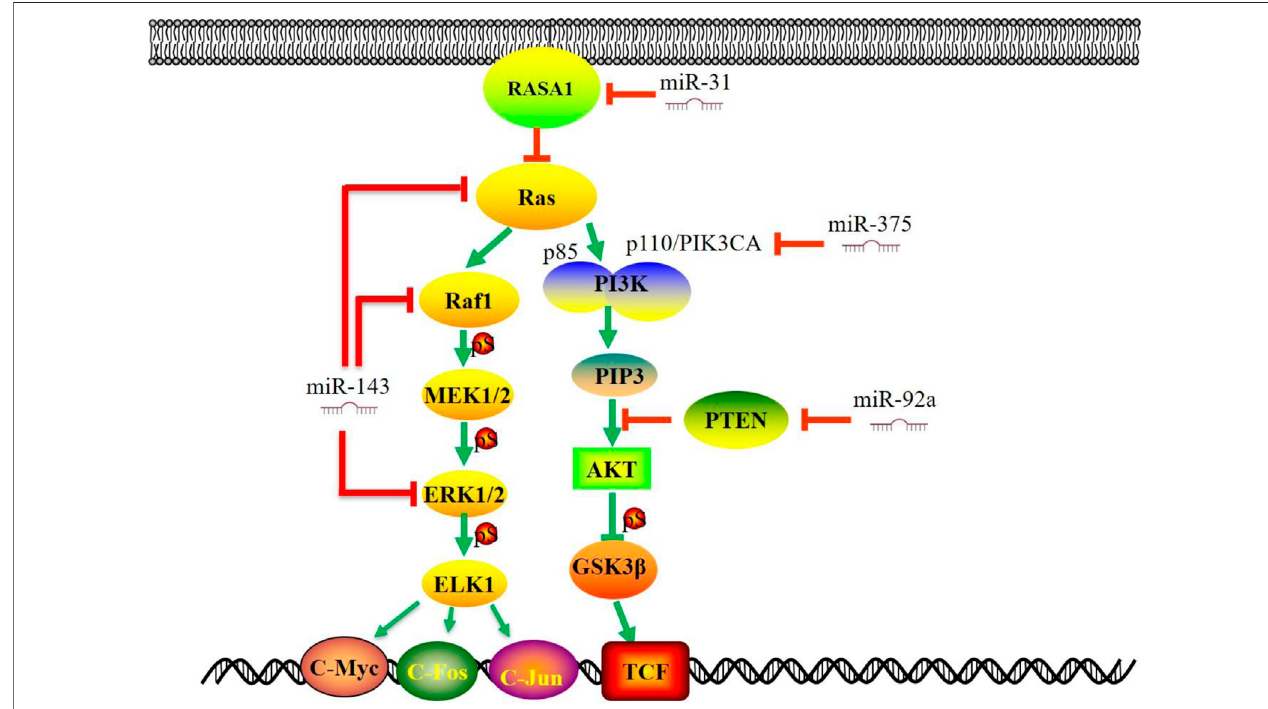
FIGURE3| MiRNAsregulateRas-Raf-MAPKandPI3K/AKTsignalingpathwaysinCRC.SeveralstudieshavedemonstratedthatmiRNAstargetthekeymolecules intheMAPKsignalingpathway(RAS,RAF,ERK,MEK5,ELK1etc.).ThediversityofalterationsinthePI3K/AKTsignalingpathway(p110,p85,AKT,PTEN,etc.)provides multiple molecular targets for therapy and raises the challenge of CRC. This fi gure summarizes that some signi fi cant miRNAs are involved in CRC progression by targeting critical molecules in MAPK and PI3K/AKT signaling pathway. miR, microRNA; PI3K, phosphatidylinositol 3-kinase; PTEN, phosphatase and tensin homolog; GSK3 β , Glycogen Synthase Kinase 3 Beta; RASA1, RAS P21 Protein Activator 1; TCF, T-cell factor.